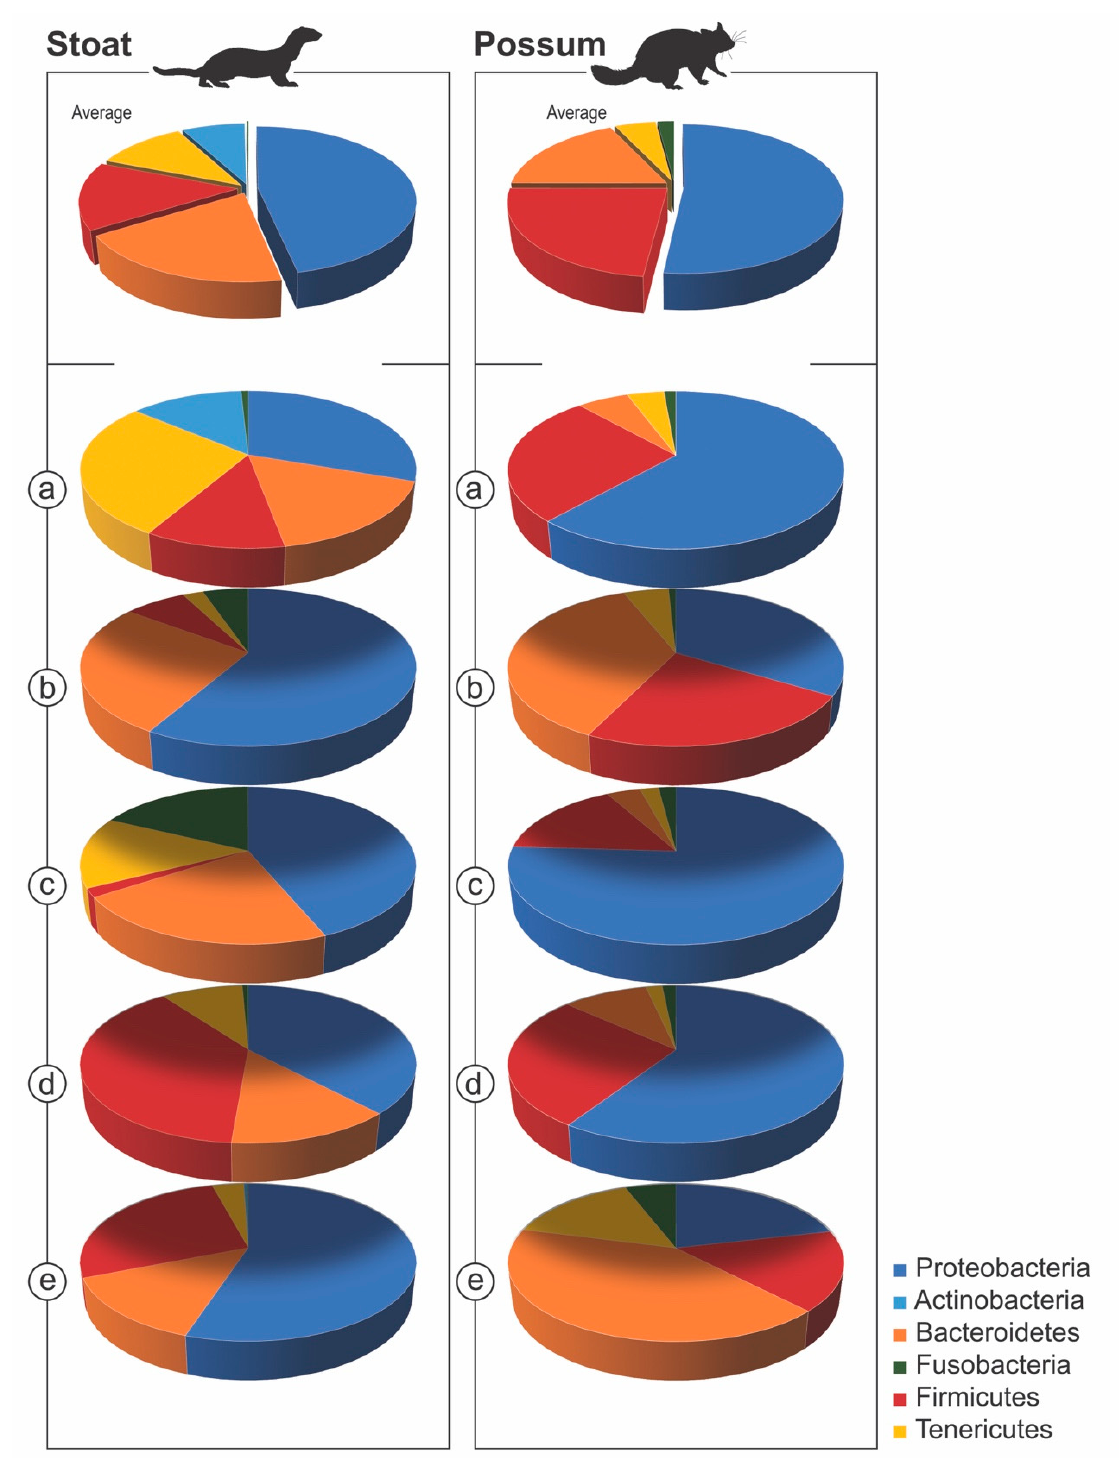
Figure 4. Inter- and intra-specific variations in the abundance of five core bacterial taxa from the oral cavities of brushtail possums and stoats. The top figure for each species depicts averages, and a–e show the variation between different individuals.